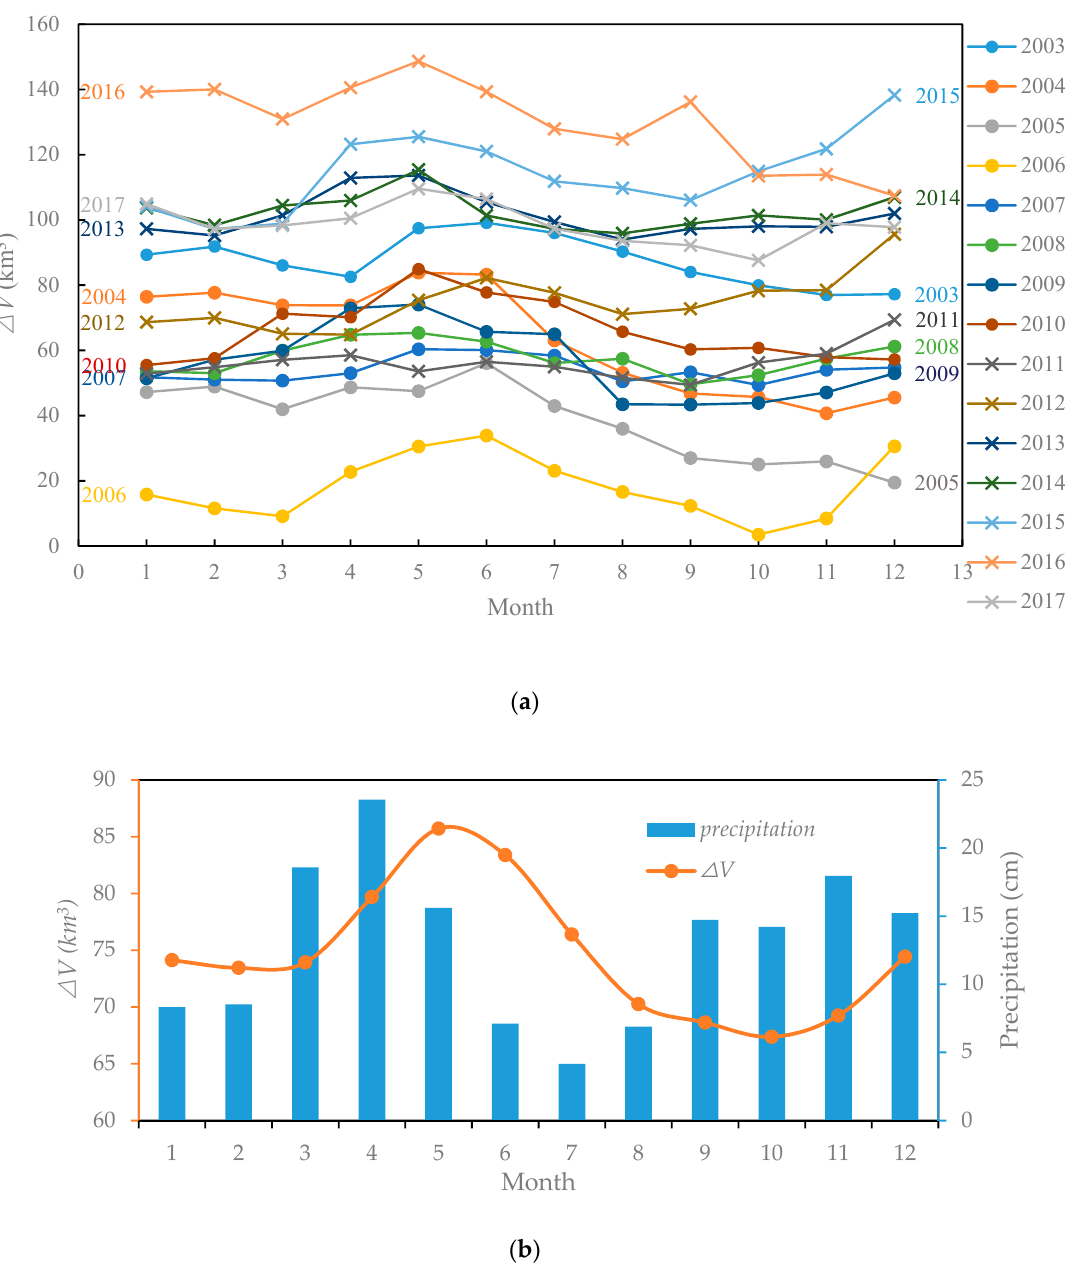
Figure 12. ( a ) Intra-annual analysis of ∆ V (2003–2017); ( b ) monthly average of Lake Victoria’s ∆ V and precipitation (2003–2017).